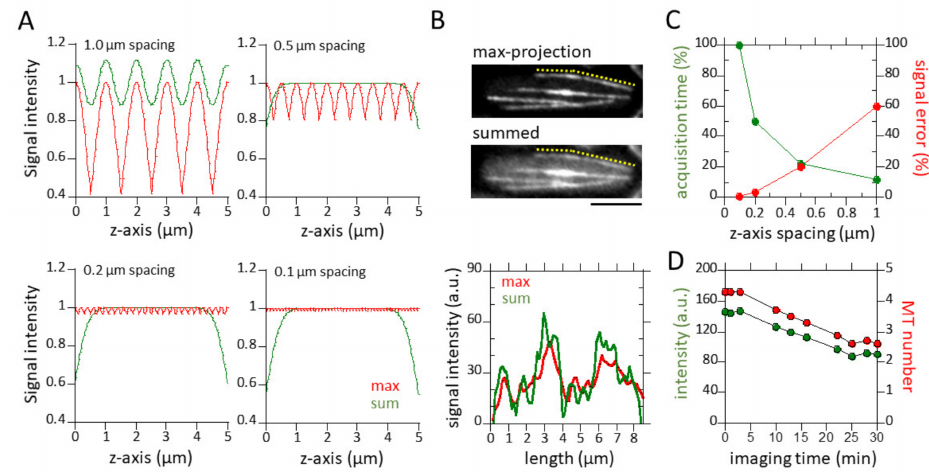
Figure 1. Practical parameters for quantitative fluorescence measurements. ( A ) Shown are normalized intensity plots at four different z-spacings (0.1, 0.2, 0.5 and 1 µ m) of a 5- µ m-thick section required to cover the complete thickness of a typical fission yeast cell (4 µ m diameter). Intensity measurements at each z-spacing can yield an error if the object measured is out of focus. Error is highest when an object is half-way between two in-focus z-planes (red lines). The spacing between two z-planes determines the magnitude of measurement error, i.e., 0.1 µ m z-spacing gives a 1% error, whereas 1 µ m z-spacing gives a 40% error. Error approaches 0% when the intensities of all z-planes are summed (green lines). Note that at 1 µ m z-spacing, the summed intensity began to show significant error. (See Methods). ( B ) Maximum-projection and summed images of a fission yeast cell expressing GFT-Atb2 (tubulin). Interphase MT bundles are shown. Yellow dotted lines approximate the MT bundle scanned. The accompanying bottom plot shows intensity line scans of the max-projected MT and the summed MT. ( C ) Shown is an optimization plot of z-spacing error versus total z-planes. The required total z-planes depends on the z-spacing and sample thickness, i.e., 51 planes are required at 0.1 µ m spacing to cover a 5- µ m-thick sample, whereas only six planes are required at 1 µ m spacing to cover the same thickness. Correspondingly, the time to capture the required total planes also depends on the z-spacing, i.e., the time required for six planes is 12% of the time required for 51 planes. The intersection of the z-spacing error and total z-planes (time) yields the optimized z-spacing of 0.5 µ m for a 5- µ m-thick sample. ( D ) Plot showing photobleaching versus time. Under our imaging condition (see Methods), the cytoplasmic signal of GFP-Atb2 decreases ~40% after 30 min imaging time. This represents a counting error of ~2